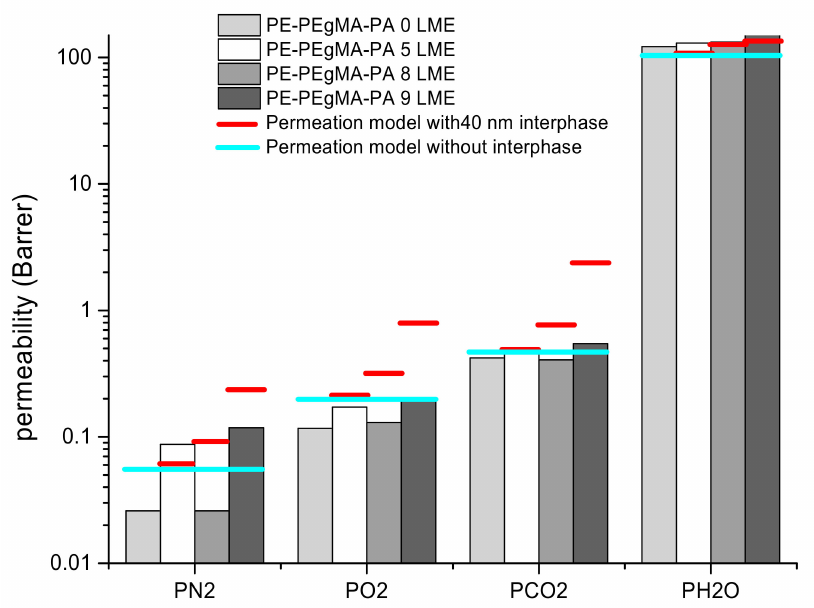
Figure 10. Permeability values for 25/50/25 wt % 0, 5, 8 and 9 LME PE/PEgMA/PA6 with serial model including interphase